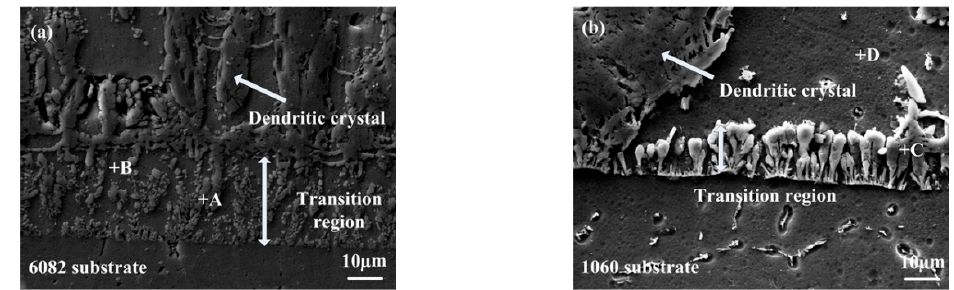
Figure 4. SEM micrographs of the transition regions on ( a ) AlN-6082 and ( b ) AlN-1060.